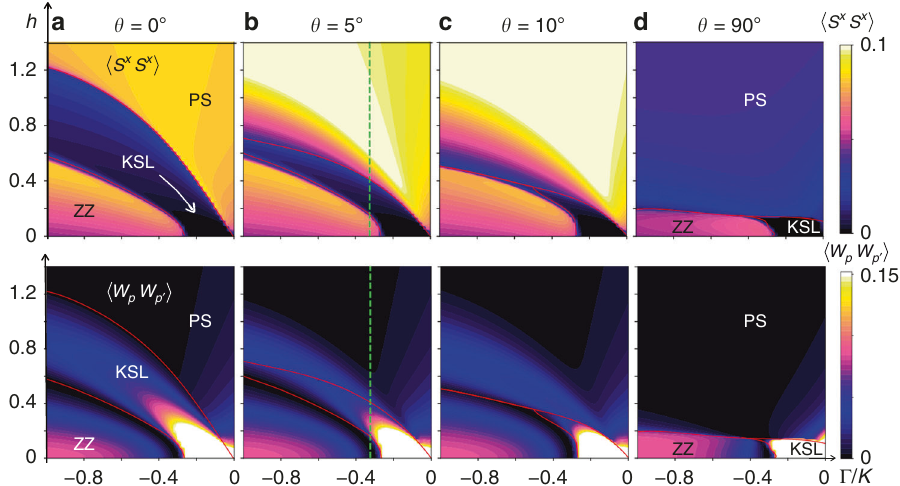
D E at k − j = 50 along the leg of the strip with maximal correlations is shown in the fi rst row, Fig. 4 DMRG phase diagrams. The spin – spin correlator S x j S x k (cid:5) (cid:6) and the plaquette-plaquette correlator W p W p ′ at p ′ − p = 30 in the second as a function of Γ / K and h with Γ ′ = − 0.1. These are obtained in the two-leg honeycomb strip using DMRG with N = 200 and OBC. The fi eld directions are constant in a given column, which are a θ = 0°, b θ = 5°, c θ = 10°, and d (cid:7) (cid:8) θ = 90° ( 11 (cid:2) 2 in-plane). Smooth curves fi tted to peaks in either χ h , or χ Γ / K are drawn with red lines. The white arrow in the spin – spin correlators of a indicates the smooth connection from the intermediate phase to the pure Kitaev limit. The dashed green line at Γ / K = − 0.325 indicates a representative slice where certain quantities are plotted in Fig. 5 for a θ = 5° tilted fi eld